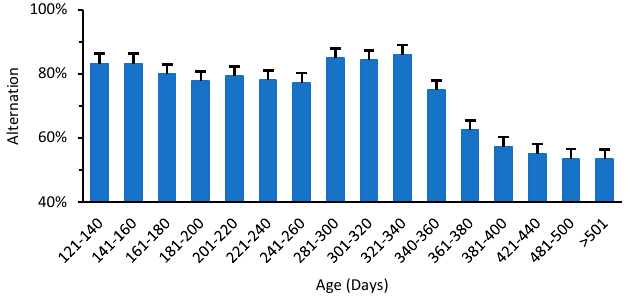
Figure 5. Percentage of spontaneous alternation rate in the T-maze test. Data indicate average ± SEM.